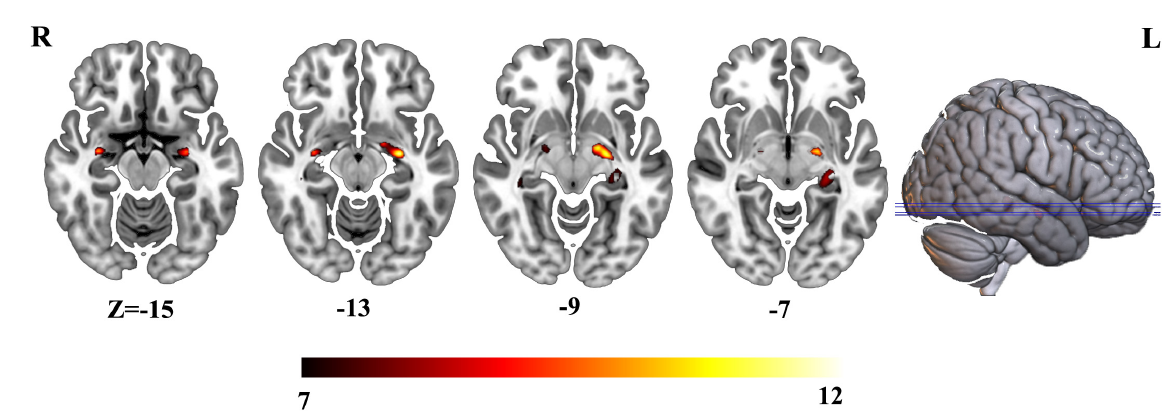
FIGURE1 Differential voxel-wise gray matter volume across three groups.